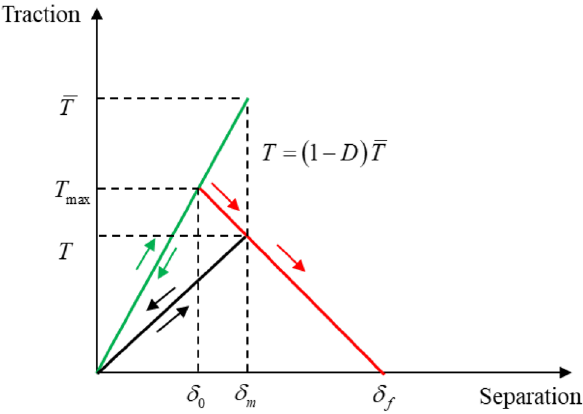
Fig. 16 T-S damage criterion of cohesive element Fig. 17 schematic diagram of calculation